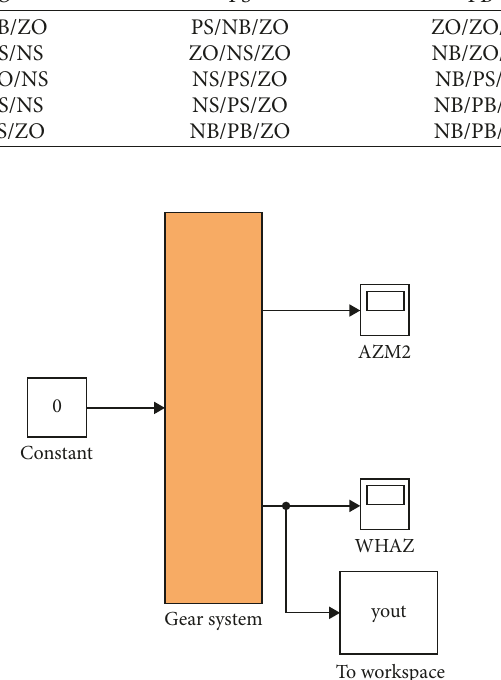
Figure 7: Acquisition of vibration signal before control.